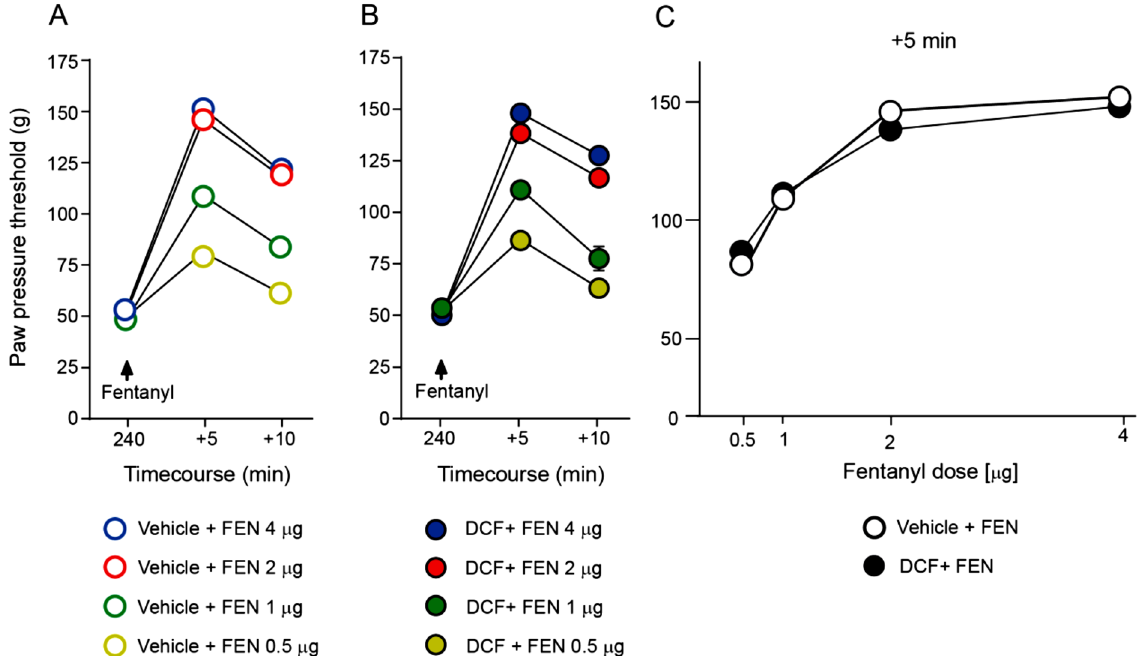
Figure 4. Antinociceptive efficacy of intraplantar (i.pl.) fentanyl after subcutaneous (s.c.) diclofenac. Dose- and time-dependent paw pressure threshold (PPT) elevations in inflamed paws after fentanyl (0.5–4 µg) injected i.pl. into inflamed paws, assessed after daily s.c. treatment with vehicle ( A ) or diclofenac (DCF; 20 mg/kg) ( B ) at 4 days after i.pl. complete Freund’s adjuvant inoculation. All PPT elevations were statistically significant ( P < 0.05 vs. 240 min, one-way RM ANOVA and Bonferroni test; not indicated for graph clarity). ( C ) PPT elevations produced by increasing doses of fentanyl (i.pl.) in inflamed paws at 5 min after fentanyl injection were not different between vehicle- and DCF-pretreated groups. P > 0.05 versus vehicle, area under the curve, two-tailed unpaired t-test. Data show means ± SEM (n = 8 rats per group).